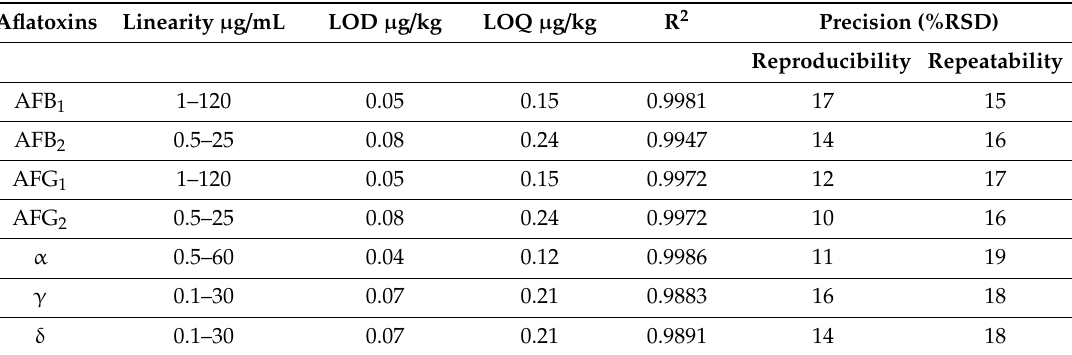
Table 1. Analytical parameters for the determination of AFs and tocopherols.